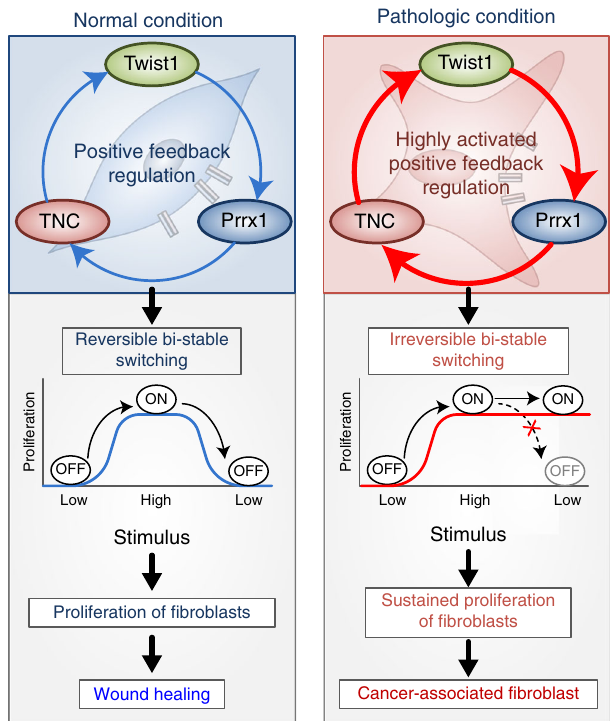
Fig. 9 Summary of our study. The Twist1-Prrx1-TNC positive feedback regulation provides clues for understanding the activation of fi broblasts during wound healing under normal conditions, as well as abnormally activated fi broblasts in pathological conditions such as cancerous and fi brotic diseases. Under normal conditions, the PFL acts as a reversible bistable switch by which the activation of fi broblasts is “ ON" above a suf fi cient level of stimulation and “ OFF" for the withdrawal of the stimulus. However, this switch can be permanently turned on under pathologic conditions by continued activation of the PFL, resulting in